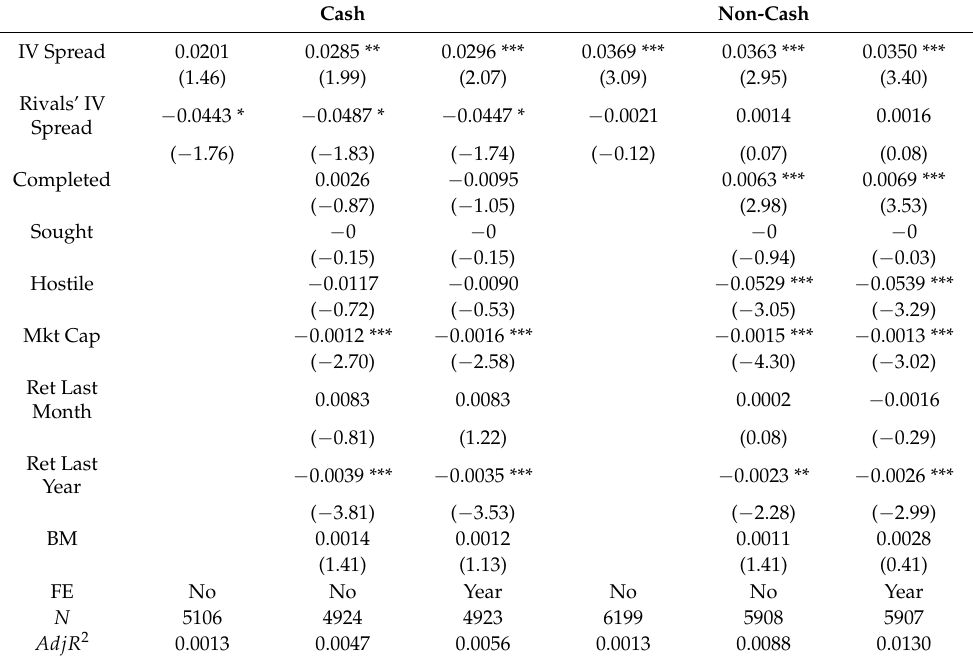
Table 10. Cash vs.